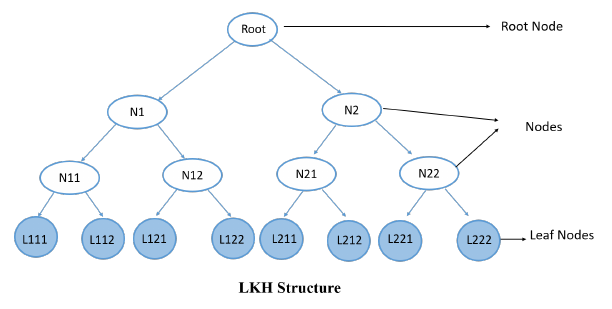
Figure 2. The figure shows an example LKH tree structure.